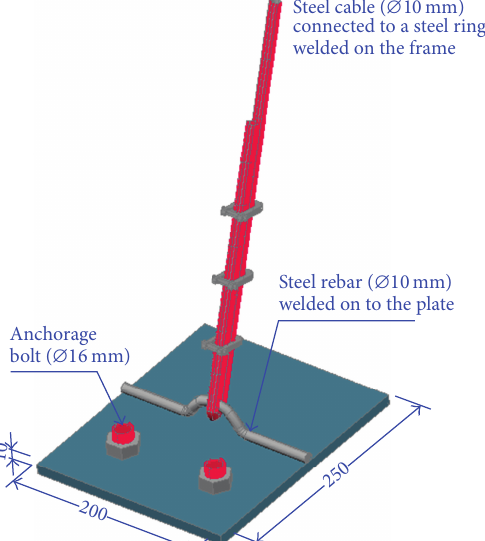
Figure 4: Base plate of the steel